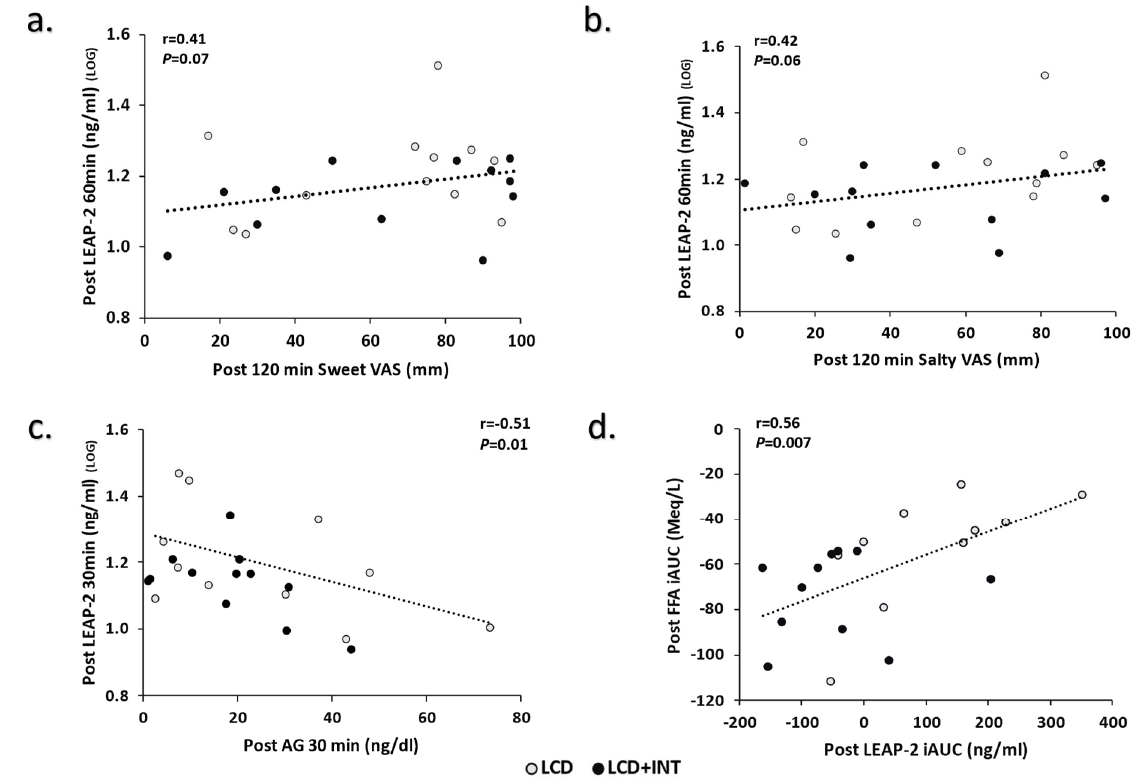
Figure 2. Correlations of LEAP-2 to Appetite, Acyl-Ghrelin, and Free Fatty Acids. Note: LOG indicates variables transformed for analysis, ( a ). Relationship between LEAP-2 and 120 min Sweet VAS post-intervention, ( b ). Relationship between LEAP-2 and 120 min Salty VAS post-intervention, ( c ). Relationship between 30 min LEAP-2 and 30 min AG post-intervention, ( d ). Relationship between LEAP-2 iAUC to FFA iAUC post-intervention, LCD: Low-calorie diet; LCD+INT: Low-calorie diet plus interval training; Gray circles indicate LCD; Black circles indicate LCD+INT; LEAP-2: Liver- expressed antimicrobial enzyme-2; AG: Acyl-Ghrelin; FFA: free fatty acid; iAUC: incremental area under the curve.